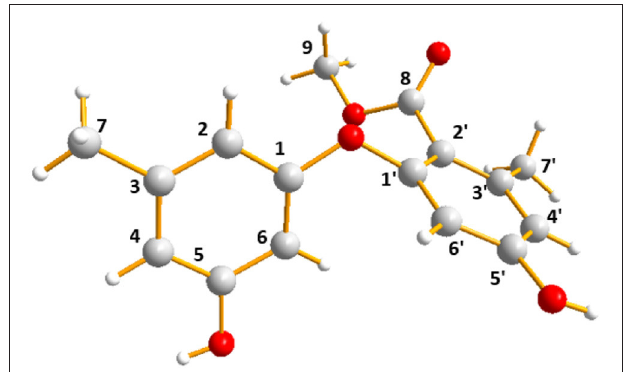
FIGURE 4 | X-ray crystallographic structure of 3 .